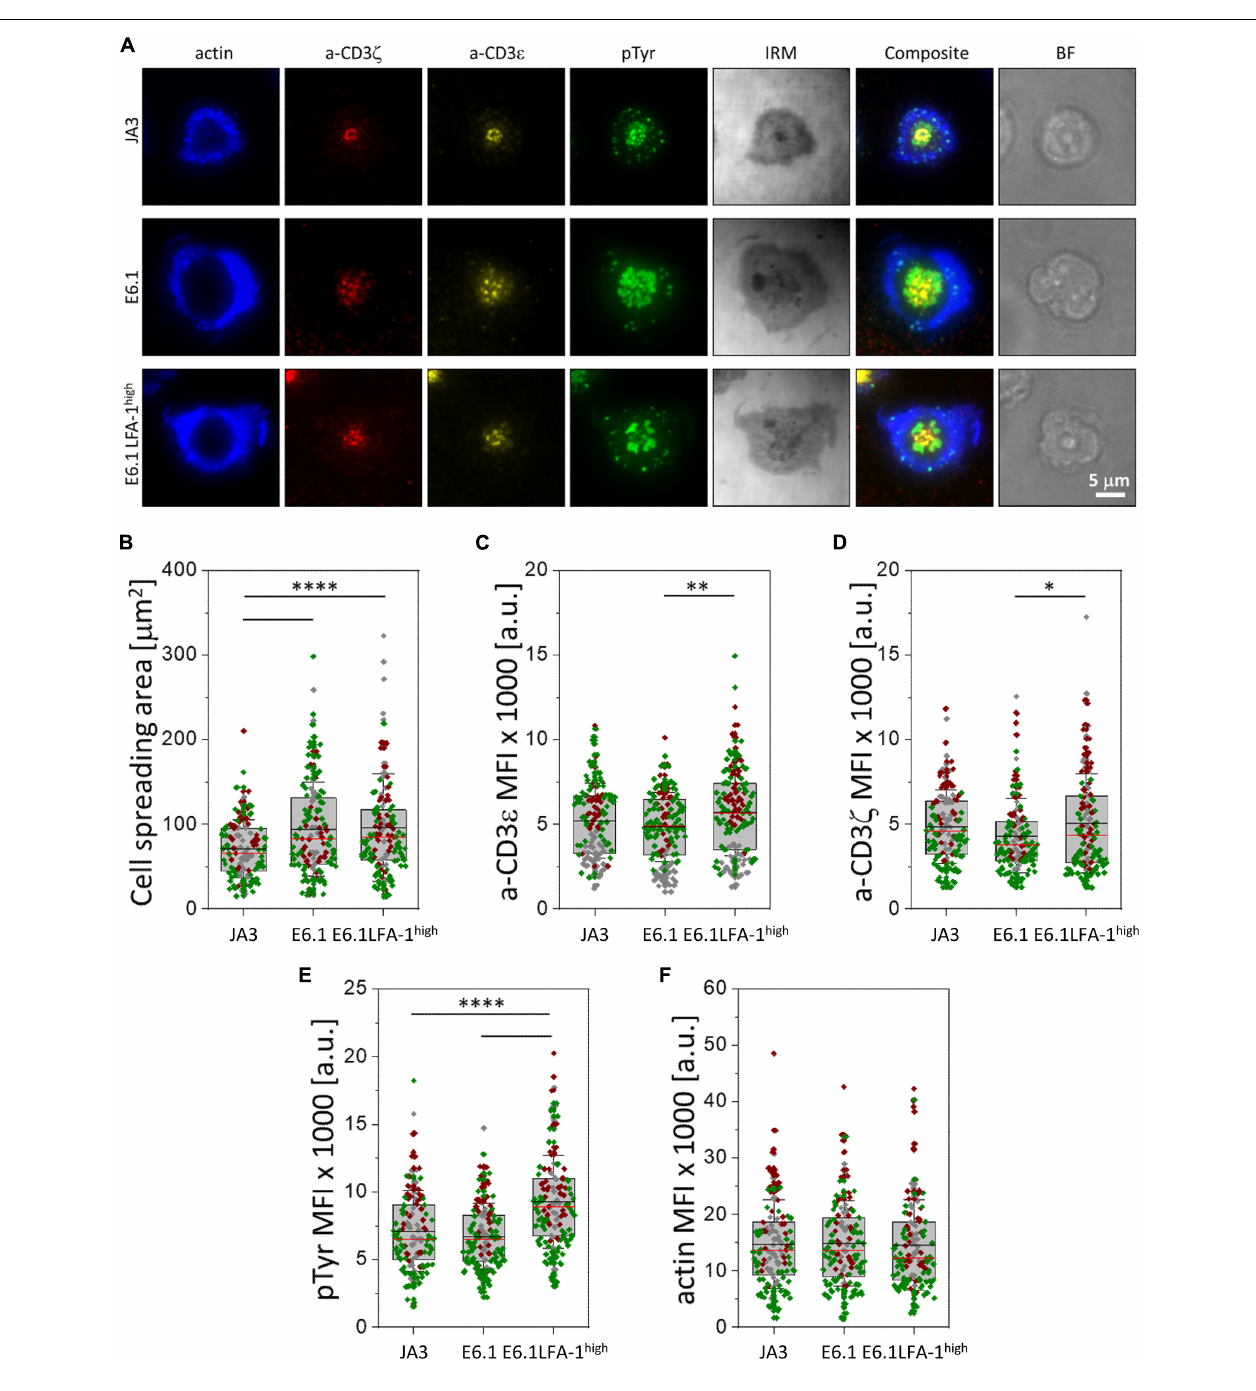
FIGURE 2 | Increasing LFA-1 expression in E6.1 cells improves phosphotyrosine signaling at the cSMAC. (A) Representative TIRFM images of E6.1, E6.1 LFA-1 high or JA3 Jurkat cells interacting with activating [ICAM1 + anti-CD3 ε UCHT1-CF568 Fab’ (yellow)] SLB for 15 min. Cells were permeabilized and stained with directly conjugated primary antibodies against anti-CD3 ζ -AF647 (red), anti-phosphotyrosine [pTyr-AF488 (green)]; the cell actin cytoskeleton was labeled with phalloidin-AF405 (blue). IRM, interference reflection microscopy; BF, bright field. Scale bar, 5 µ m. (B) Quantification of cell spreading area of different Jurkat cell lines on activating SLB as in (A) . Corresponding mean fluorescent intensity (MFI) of anti-CD3 ε (C) , anti-CD3 ζ (D) , anti-pTyr (E) and actin (F) from different Jurkat cell lines as in (A) . Horizontal lines and error bars represent mean ± SD (black line) and median (red line). Gray box represents 25–75 percentile. Data are from minimum of 130 cells from three independent experiments; each dot represents a cell; each color represents an independent experiment. One-way analysis of variance (ANOVA) with Tukey’s post hoc test. Only significant differences are shown. ∗ p < 0.05; ∗∗ p < 0.01; ∗∗∗∗ p < 0.0001.